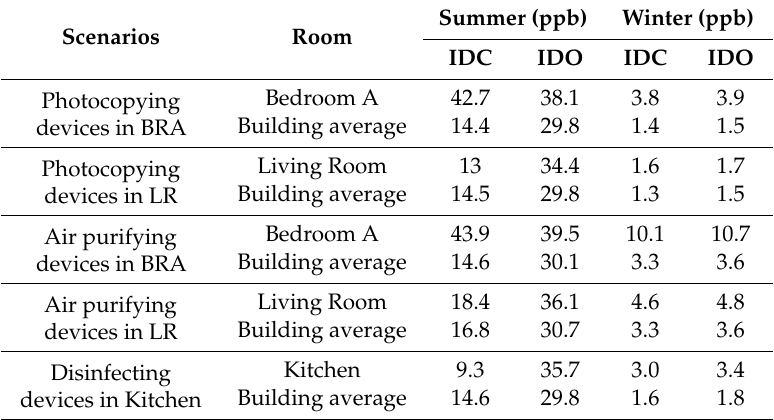
Table 5. Average ozone concentration in the source room and the building average when there were ozone emission devices indoors.